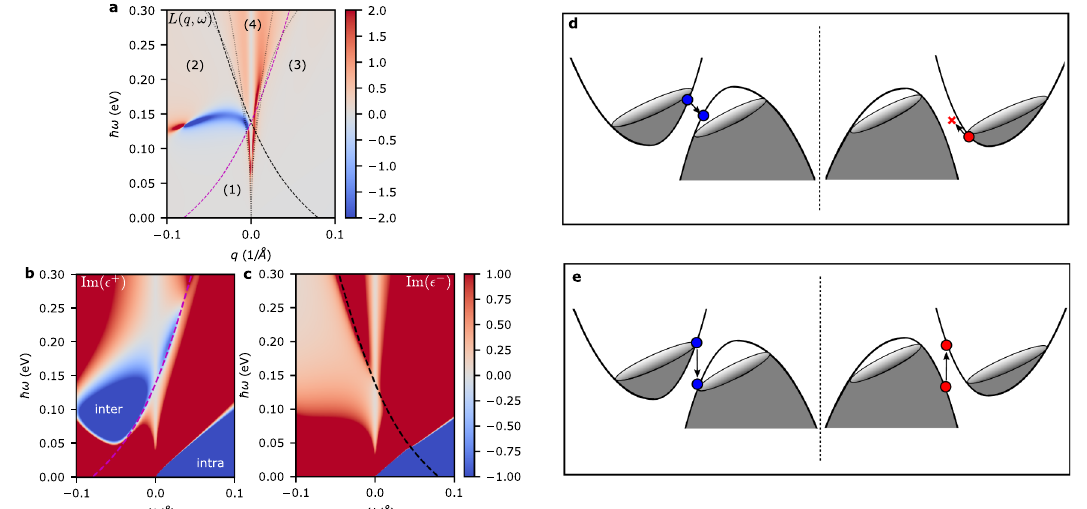
Fig. 2 | Tilted 2D massive Dirac model and loss function calculation. a Loss function L ( q x , ω ) calculation for parameters v =2.427eVÅ, t =1.16 v , m =0.138eV, α =7.541eVÅ 2 . The magenta(black) dashed lines show the interband transition boundaries for the η =+1( η = − 1) valley. Grey dashed lines show the plasmon dis- persion for zero current bias derived from a hydrodynamic